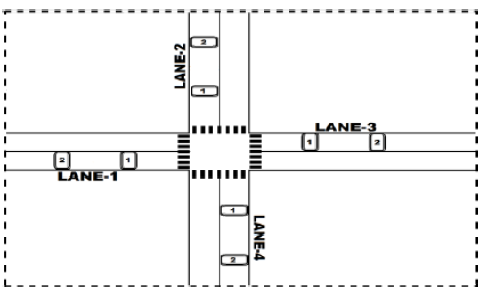
Figure 1. Identification of loop locations across the Road junction Figure 2. Each loop is of hallow rectangular/square shape in which cable is poured (3 or more turns) along the edge of the rectangle/square. There are two loops per lane connected in series in order to develop high amount of inductance. These loops are then connected to the electronics unit of ILD device placed at roadside (or